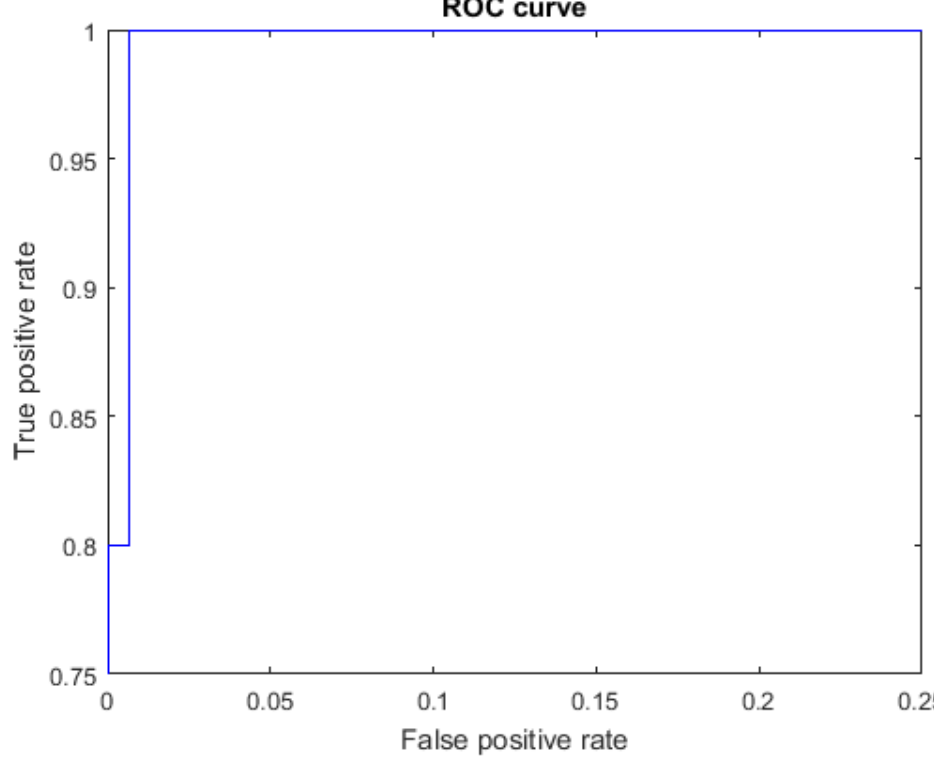
Figure 9. ROC curve for the letter N using spherical features, AUC = 0.9987.